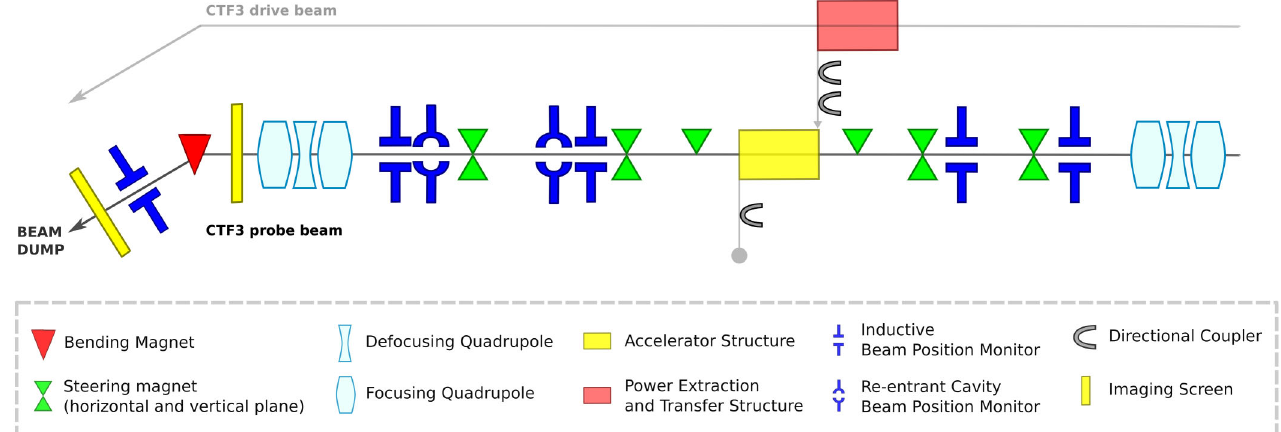
FIG. 2. Sketch of the probe beam line of the Two-beam Test Stand at the CLIC Test Facility 3. The CLIC prototype accelerator structure is fed with rf power produced in the power extraction and transfer structure installed in the drive beam line. The probe beam line is equipped with two quadrupole triplets, steering magnets, inductive and cavity beam position monitors, removable imaging screens and directional couplers at the input and output ports of the accelerator structure. A spectrometer line is used to measure the beam energy just before the beam dump.